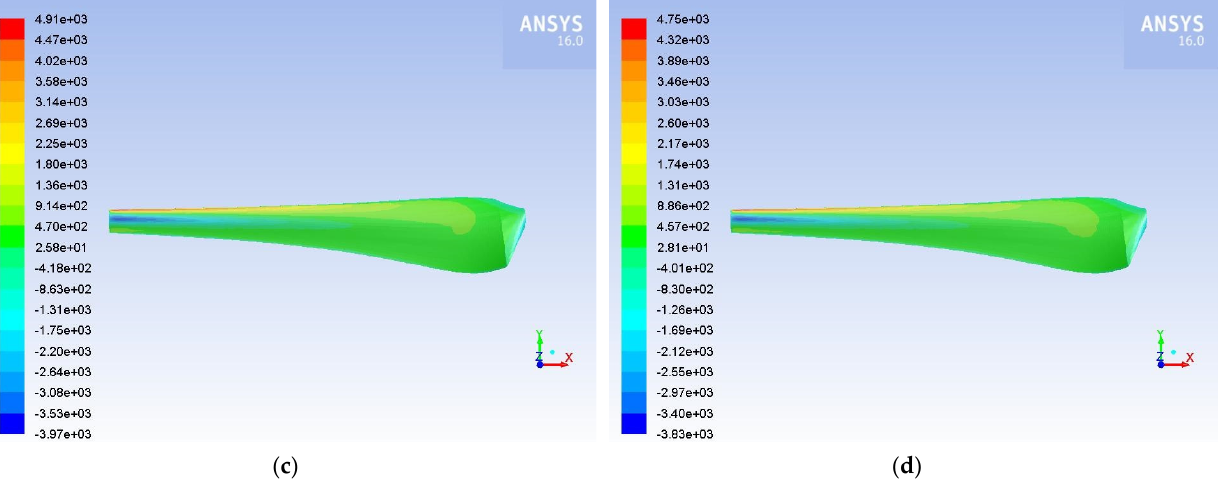
Figure 9. Static pressure contours at the blade’s pressure side and at wind speed of 15 m·s − 1 . ( a ) Q =